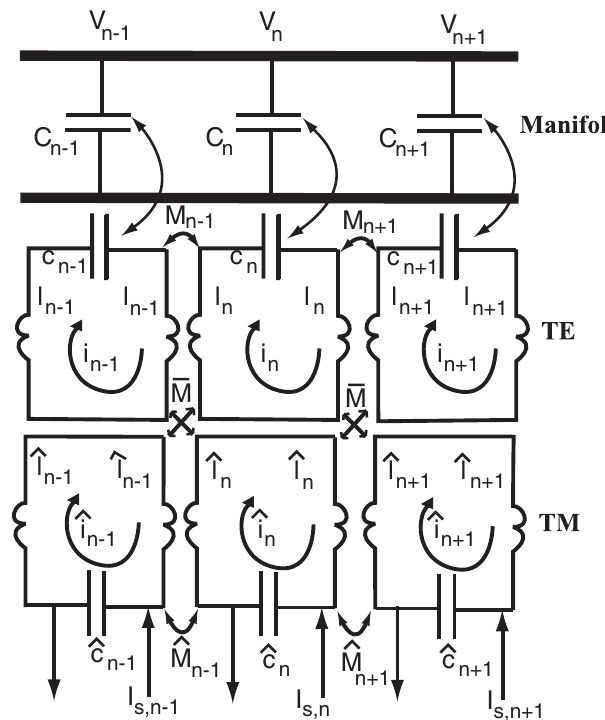
FIG. 2. Circuit diagram illustrating the hybrid TE-TM dipole mode (represented by the parallel L - C circuits) coupled to the waveguide modes (represented uppermost by the transmission line) for three cells of the main accelerating structure. The , I , and I represent the delta-source electron currents I s;n (cid:5) 1 s;n s;n (cid:6) 1 beam which is coupled directly into the lowermost TM